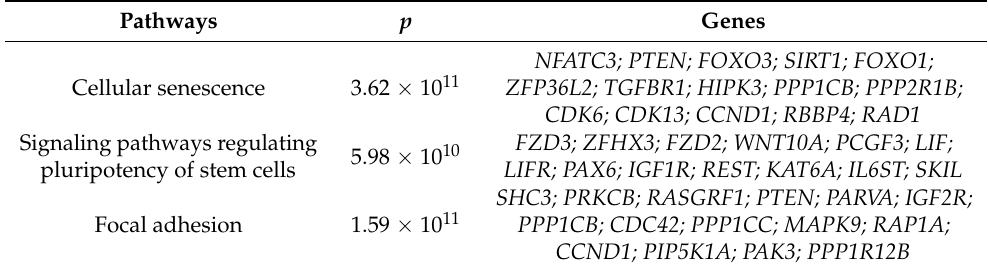
Table 6. Main pathways regulated by miR-1253, miR-1283, miR378e, and